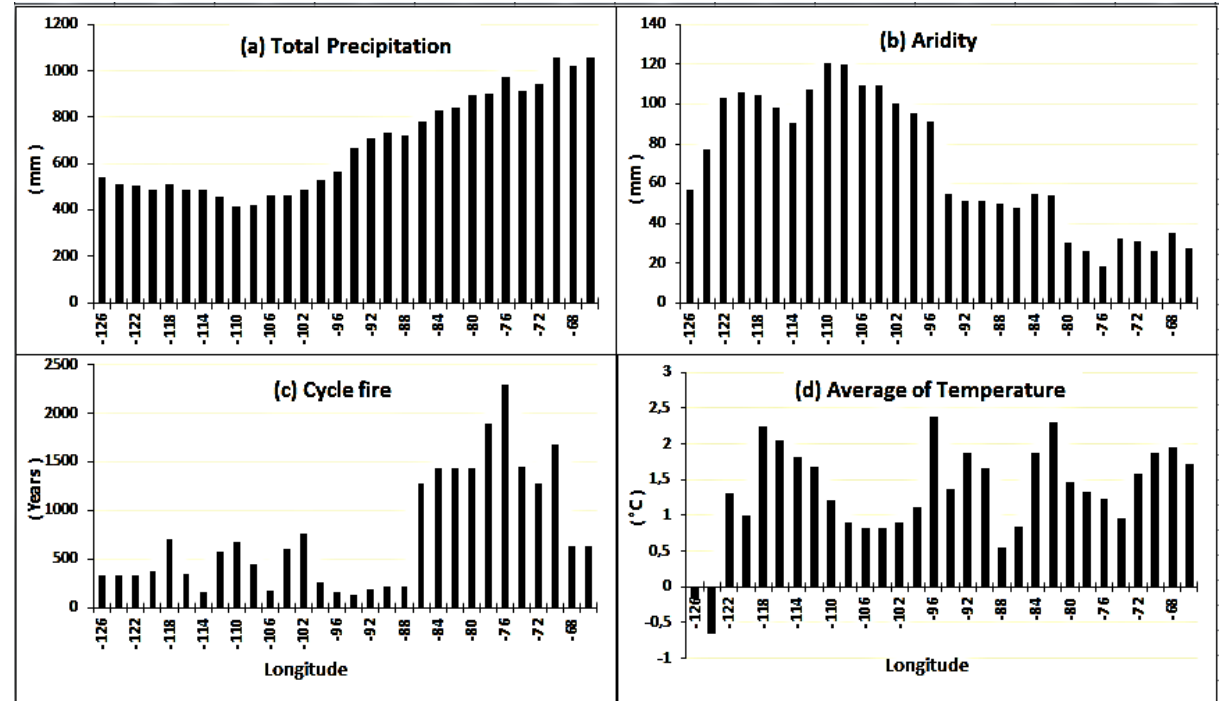
Figure A1. Histograms illustrating the variability of environmental conditions (averages of the last three decades) based on the longitudinal gradient for total annual precipitation, drought index (aridity), cycle fire and average annual temperature. The linear regression on each histogram indicates the trend of fluctuations in the distribution of the variable across the study gradient.